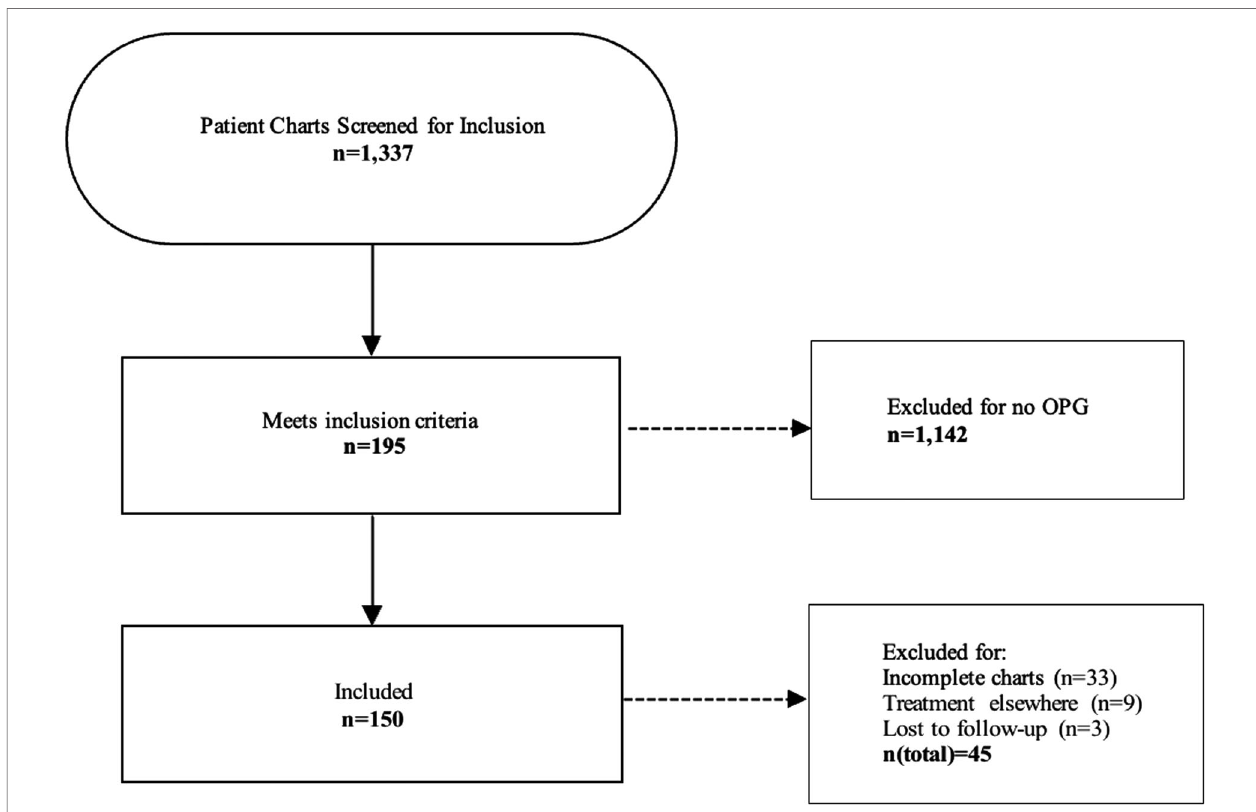
FIGURE 2 | Flowchart illustrating the process of patient screening and the exclusion criteria applied. A fi nal number of 150 patients diagnosed with NF and OPG was included in the